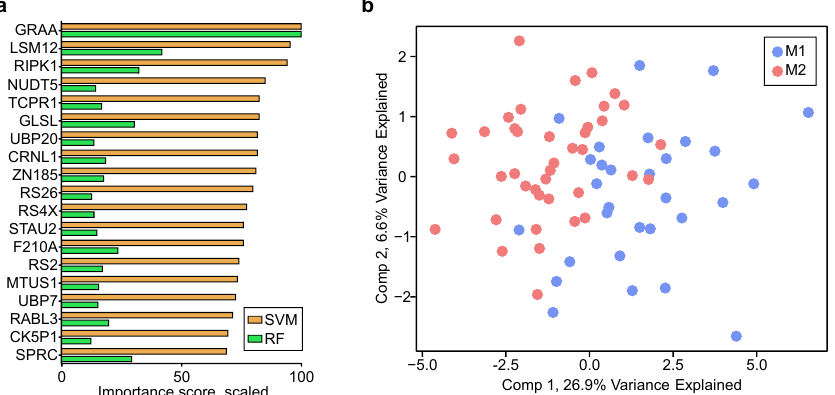
Figure 5. Supervised machine learning analysis of the 132 APs using random forest (RF) and support vector machine (SVM) algorithms. ( a ) Scaled importance of the 19 proteins overlapped between the TOP30 proteins with the highest importance in both models; ( b ) partial least squares-discriminant analysis (PLS-DA) results of the 19 proteins.